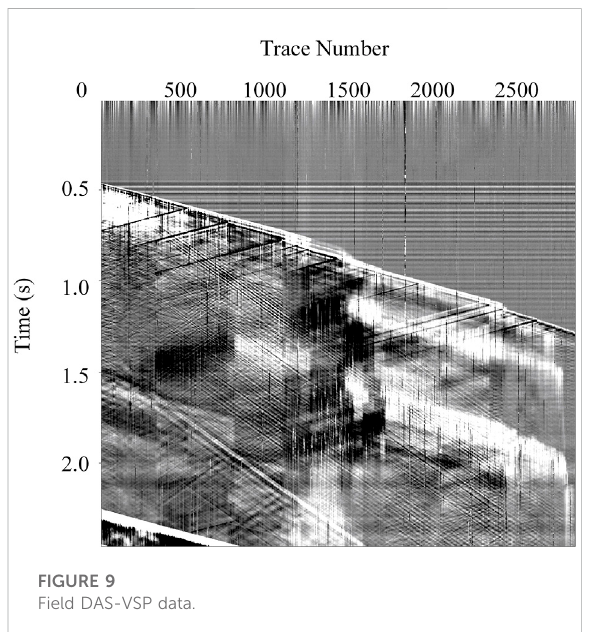
FIGURE 9 Field DAS-VSP data.